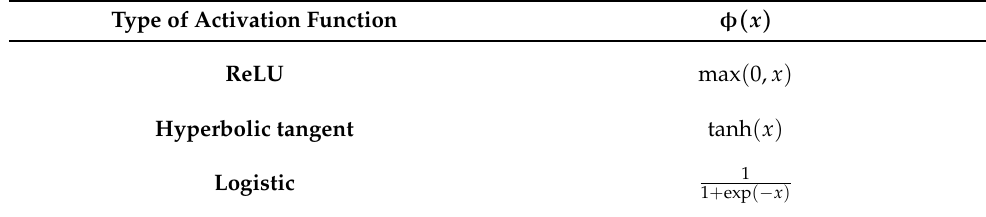
Table 4. Common activation